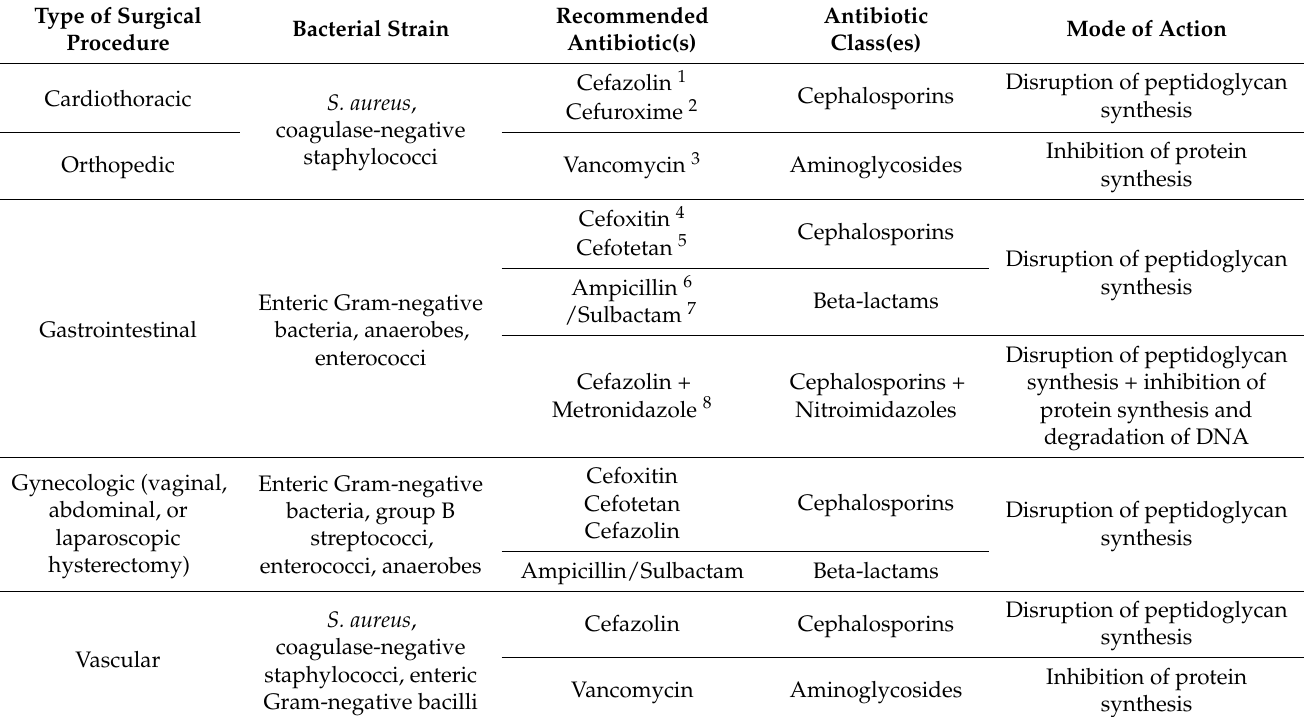
Table 1. Recommended antibiotic prophylaxis to prevent SSIs caused by bacterial strains in different types of surgical procedures and modes of action of the different antibiotic classes. Adapted from Salkind et al.